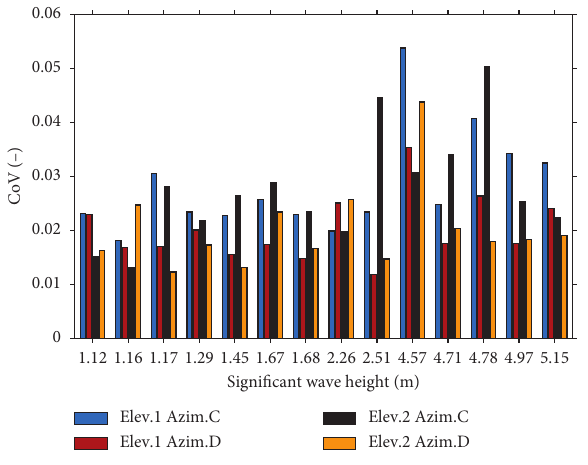
Figure 11: Coefficient of variation (CoV).